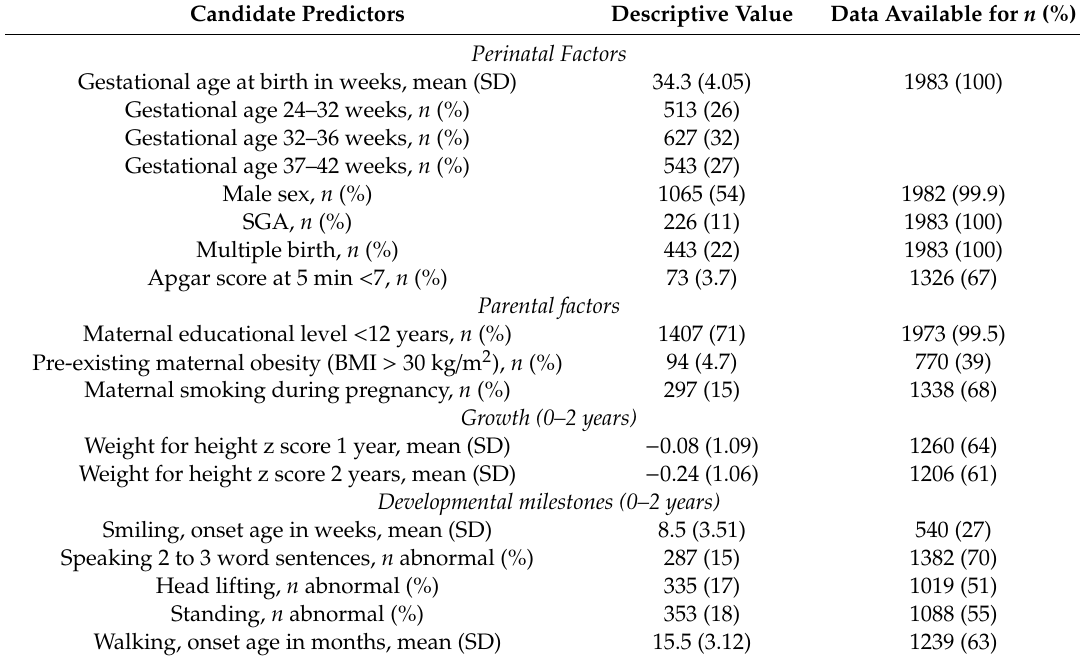
Table 1. Description of candidate predictors for the LOLLIPOP population for analysis ( N = 1983). Candidate Predictors Descriptive Value Data Available for n